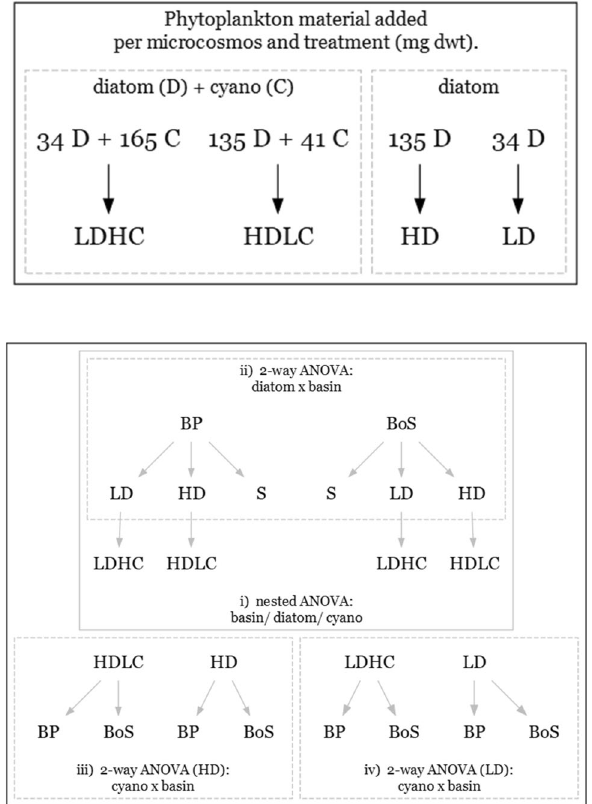
Figure 2. Summary of the experimental design and statistical approaches to test the effect of different diet regimes ( LD low diatom, HD high diatom, LDHC low diatom high cyanobacteria, HDLC high diatom low cyanobacteria, S sediment only) on amphipods from the BP and BoS basins. The phytoplankton material added per microcosm in the experimental treatments and expressed as dry mass (mg dwt) of the diatoms and cyanobacteria for high and low levels of each food type. See details on statistical tests in the